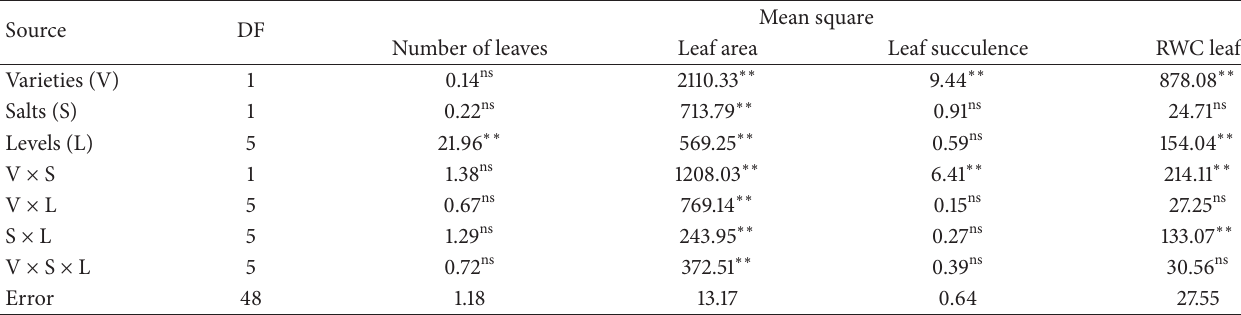
Table 3: Analysis of variance (ANOVA) table for number of leaves, leaf succulence, leaf area, and relative water contents of leaf recorded at vegetative stage of sunflower grown under different levels of rhizospheric